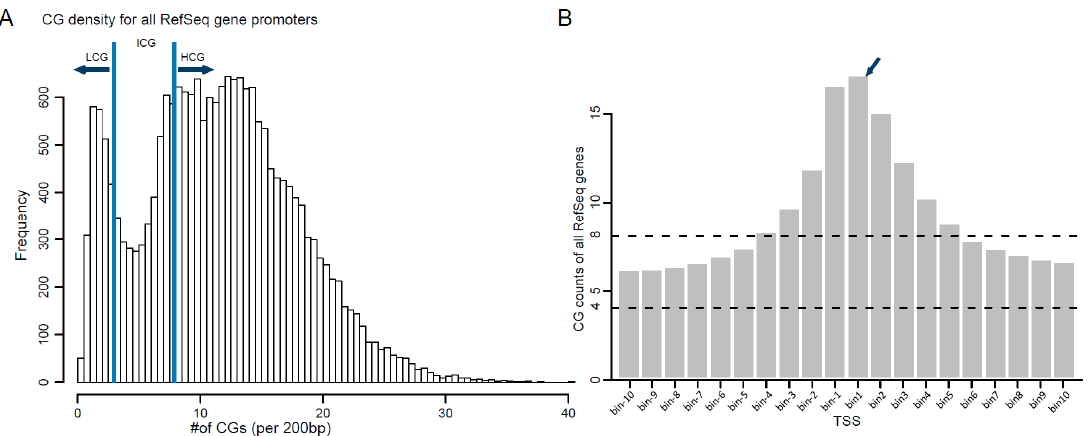
Figure 5. The CG density and distribution of the 20 consecutive bins in promoter regions. ( A ) Clas- sification of the CG density for all RefSeq gene promoters. The promoters were separated into three classes: (1) HCG, more than 8 CGs per 200 bp; (2) LCG, less than 4 CGs per 200 bp; (3) ICG, 4–8 CGs per 200 bp. ( B ) Distribution of CG counts at the 20 bins of all RefSeq genes. The number of CGs at bin1 was the highest.